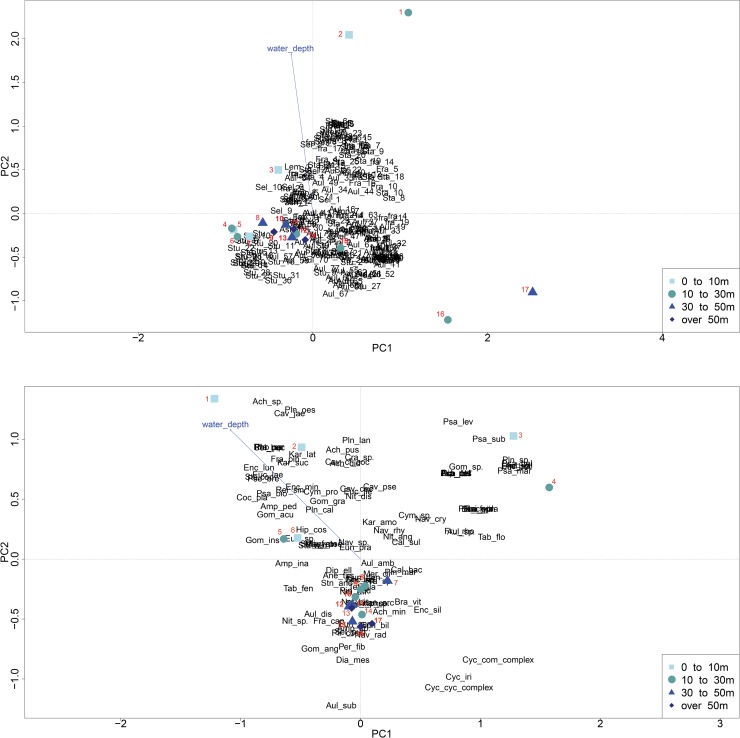
Principal component analysis (PCA).PCA of the diatom assemblies retrieved from the genetic approach (a) and the morphologically identified diatom taxa (b) with the water depth fitted on the ordination plot. Numbers in the genetic plot denote the following sites: 1 –PG2122, 2 –PG2123, 3 –PG2142, 4 –PG2140, 5 –PG2137, 6 –PG2147, 7 –PG2146, 8 –PG2209, 9 –PG2205, 10 –PG2144, 11 –PG2118, 12 –PG2141, 13 –PG2115, 14 –PG2113, 15 –PG2124, 16 –PG2125, 17 –PG2117. Numbers in the morphological plot denote the following sites: 1 –PG2123, 2 –PG2142, 3 –PG2146, 4 –PG2141, 5 –PG2122, 6 –PG2137, 7 –PG2144, 8 –PG2147, 9 –PG2140, 10 –PG2124, 11 –PG2209, 12 –PG2117, 13 –PG2113, 14 –PG2125, 15 –PG2115, 16 –PG2205, 17 –PG2118.